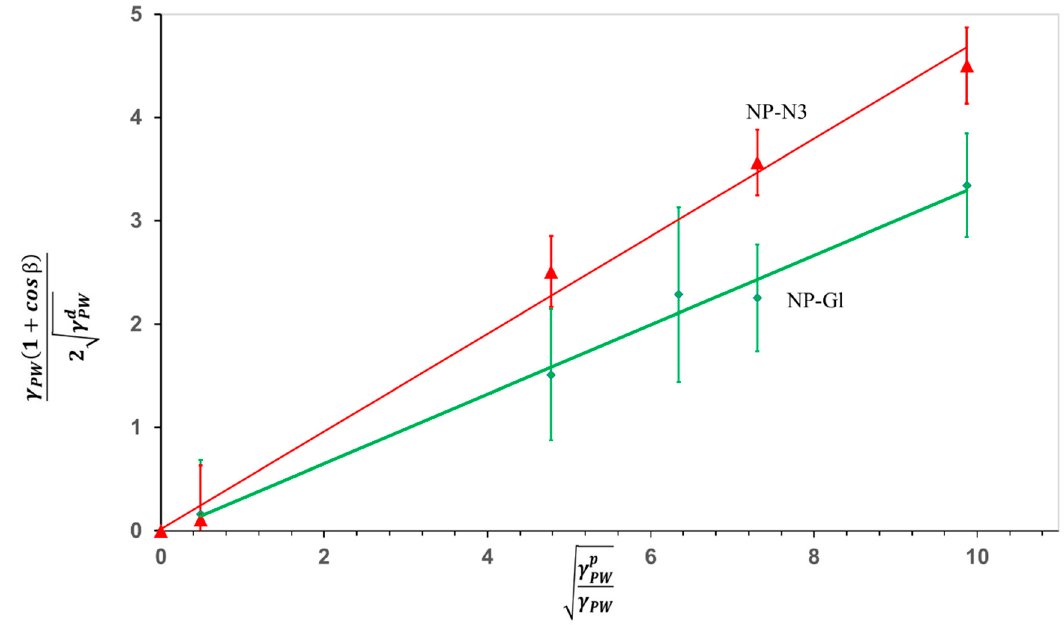
Figure 6. The linear OWRK equation was constructed from the experimental data of the contact angle measured from the circular traces left by the nanoparticles NP-Gly and NP-N 3 . The error bars represent the standard error and are represented both on the positive and negative side of the measured average value.